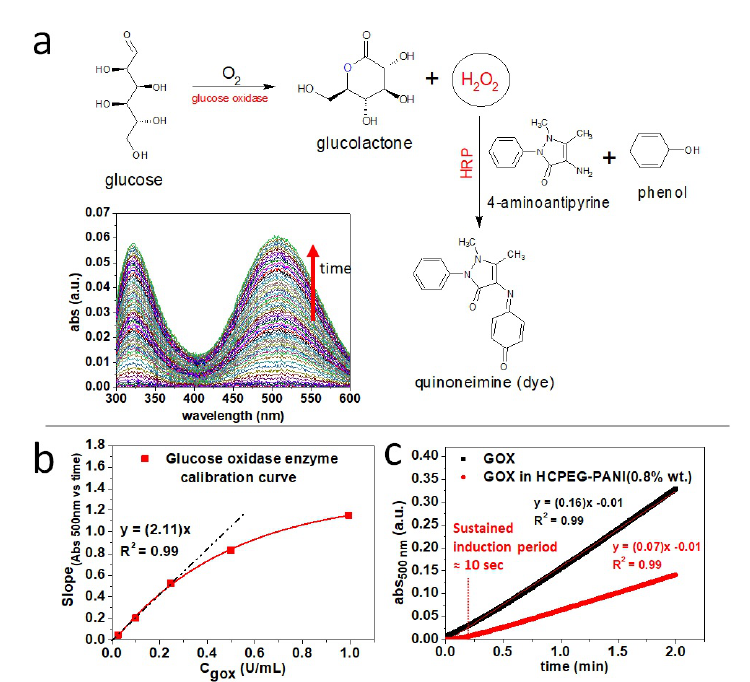
Figure 7. Porous monolithic HCPEG − PANI(8% wt) functionalized with glucose oxidase enzyme. ( a ) Colorimetric assay reaction and UV visible spectra; ( b ) glucose oxidase enzyme activity col- orimetric calibration curve; ( c ) comparison between glucose oxidase enzyme activity in solution (1 Units/mL, PBS 100 mM, ph = 7.3) and embedded (1 Units/mL, PBS 100 mM, ph = 7.3) in the porous monolithic HCPEG − PANI (8%